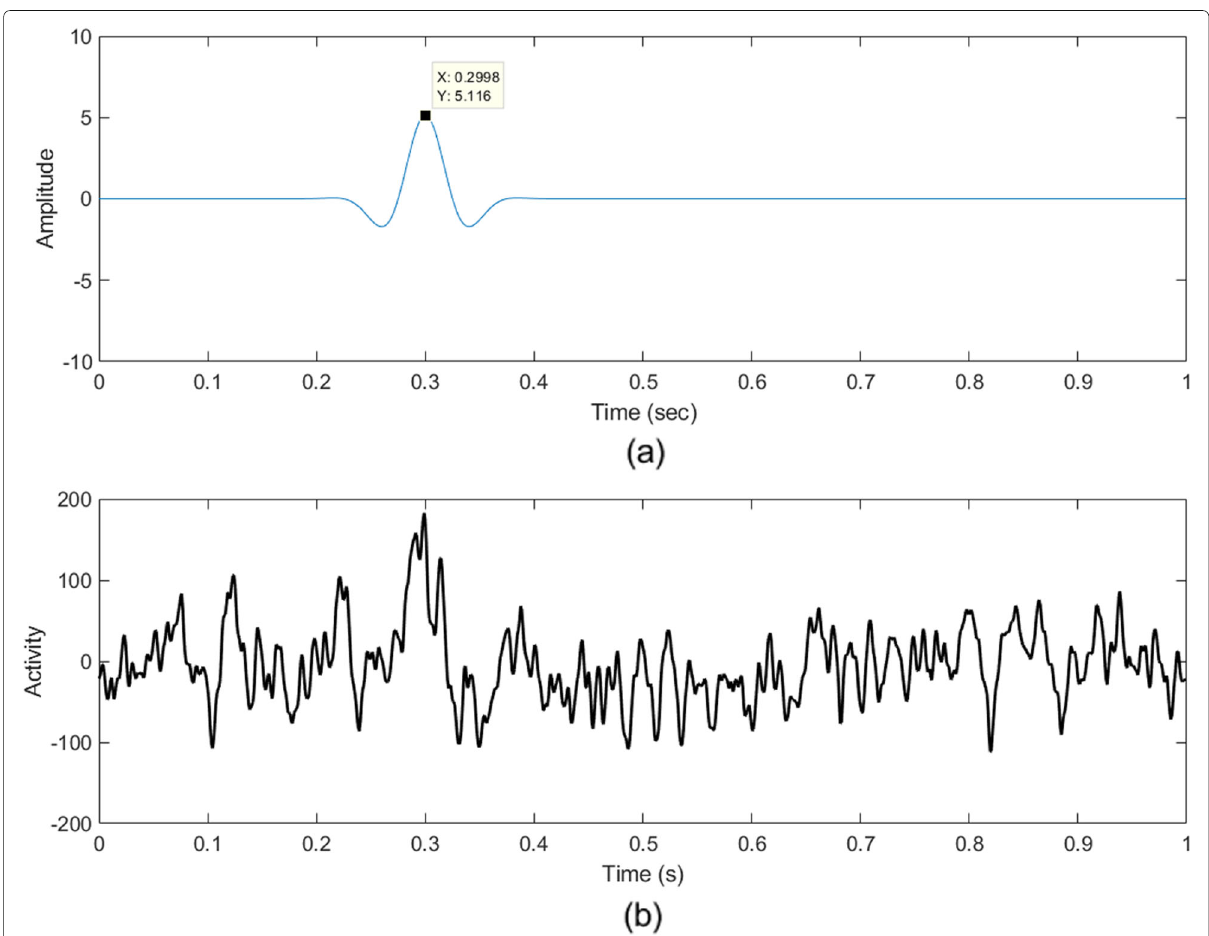
Fig. 2 a Average of 30 phase-shifted Morlet wavelets at dipole 637. b Average of 30 trails at electrode